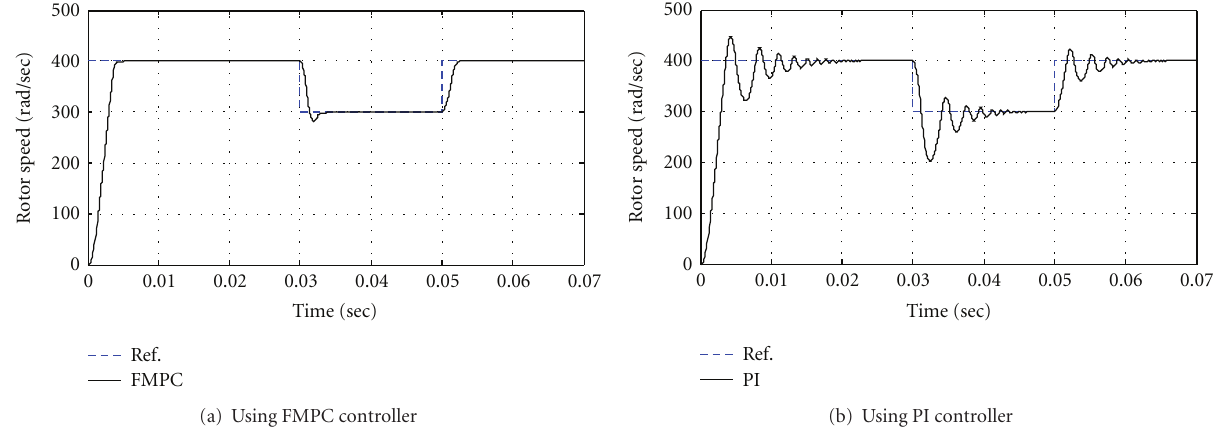
Figure 3: Speed response of the PMSM system based on FMPC and PI controllers.